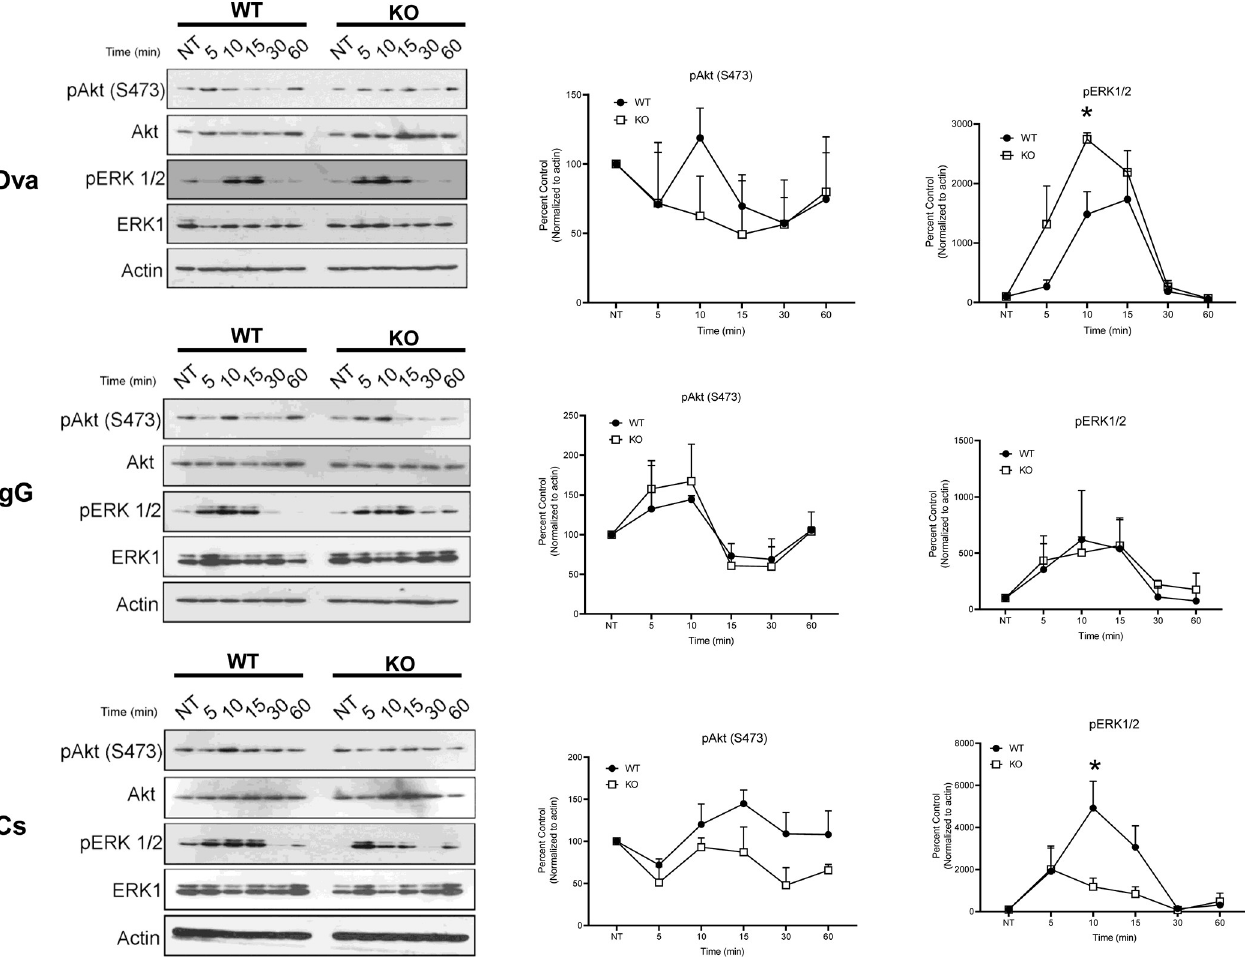
Fig 6. Western blot analysis of Akt, phospho-Akt, ERK1/2 and phospho-ERK1/2 expression in WT and FcRn KO poodcytes treated with NP-ovalbumin (Ova), IgG or immune complexes (ICs). * , P < 0.05, n = 3 independent experiments.